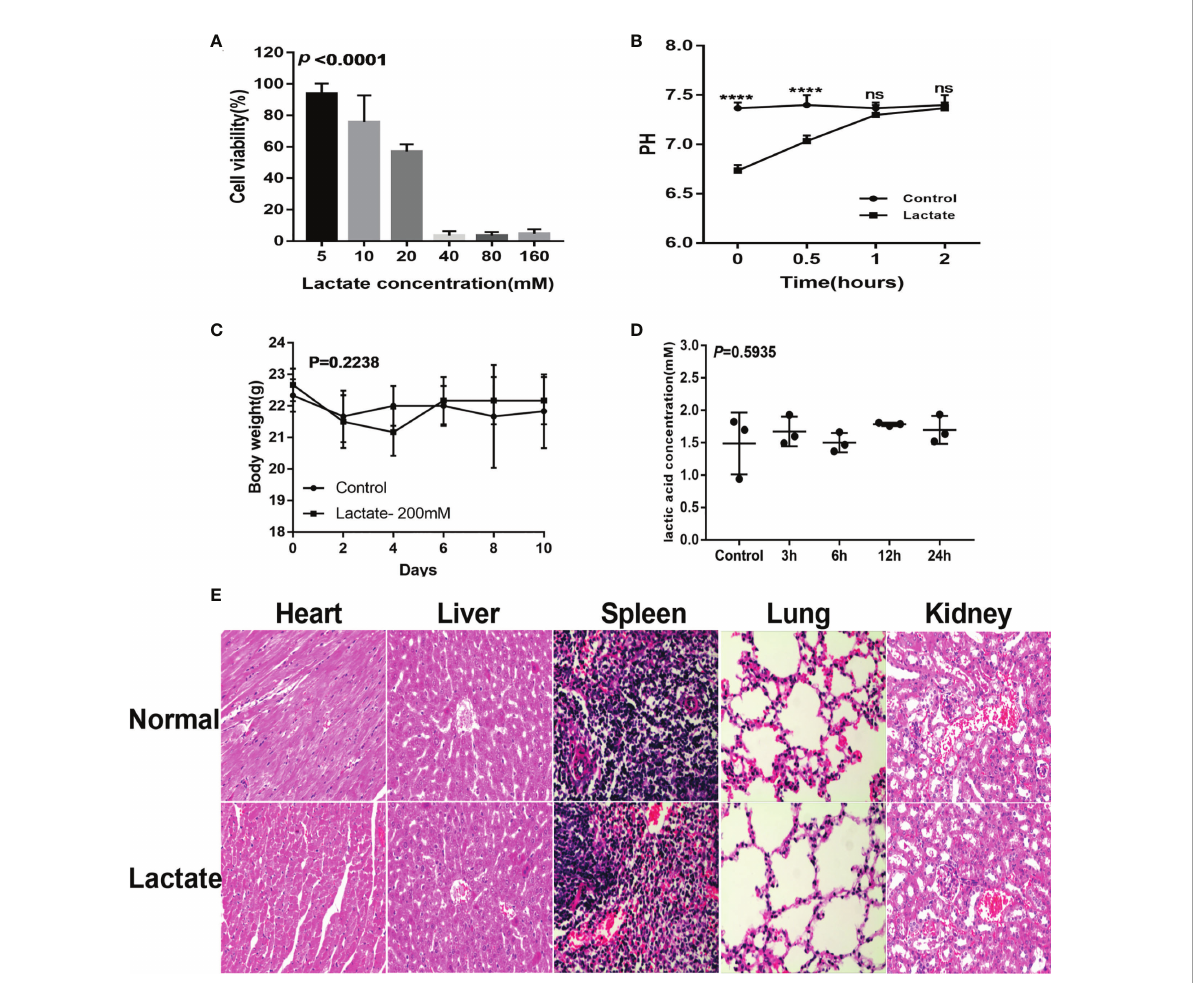
FIGURE 6 Safety evaluation of lactate. (A) The cytotoxicity results determined by the CCK8 assay (n=3). (B) Lactate was added to the cell culture media. pH was measured over 2 hours. (C) Effects of lactate on body weight in normal mice (N=6). (D) Effect of exogenous lactic acid on serum lactic acid in normal mice (n=3). (E) Effect of lactate on organs of normal mice